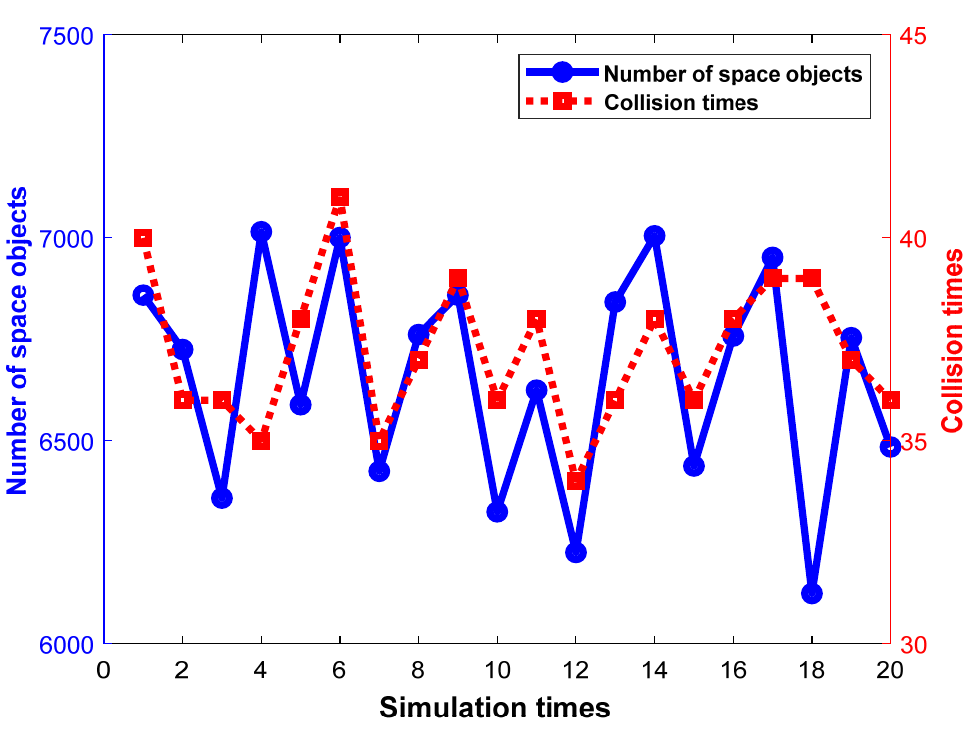
Figure 5. Twenty simulation experiments of scenario 3. The simulations with the largest and smallest numbers of space objects after 100 years in this scenario are shown as Figure 6. The red dotted lines represent the total number of collisions since the first collision at 0:00 on 1 February 2022, and the blue solid lines rep- resent the number of space objects larger than 0.05 m in the GEO band.